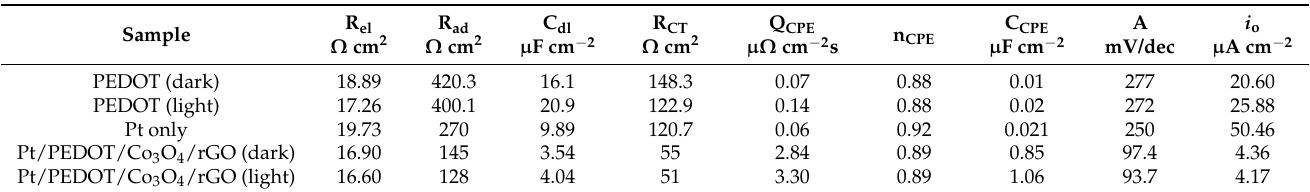
Table 1. Data from EIS; R el = ohmic resistance, R ad = adsorption resistance, C dl = diffuse layer capacitance, R CT = catalytic charge transfer resistance. Q CPE , n CPE , and C CPE describe the capacitance expressed in terms of a constant phase element. The last two columns depict data from the Tafel plot studies in Figure 7d: slope A (in mV/decade), exchange current density, i o (in mA/cm 2 ). (‘dark’ = without light illumination; ‘light’ = with light illumination).